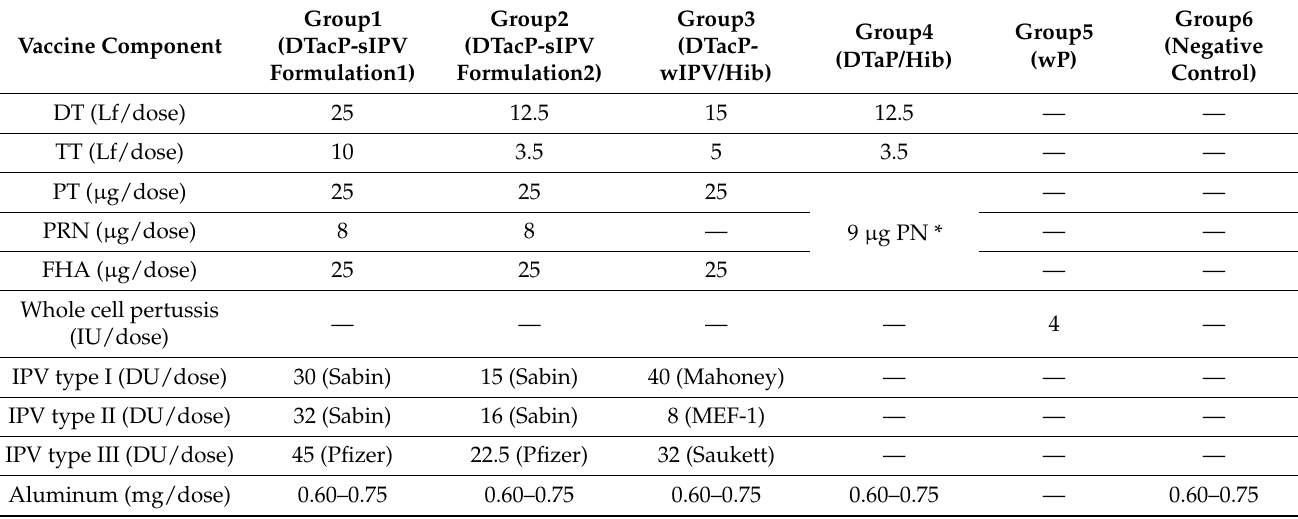
Table 1. Composition and grouping of experimental and control vaccines used in the